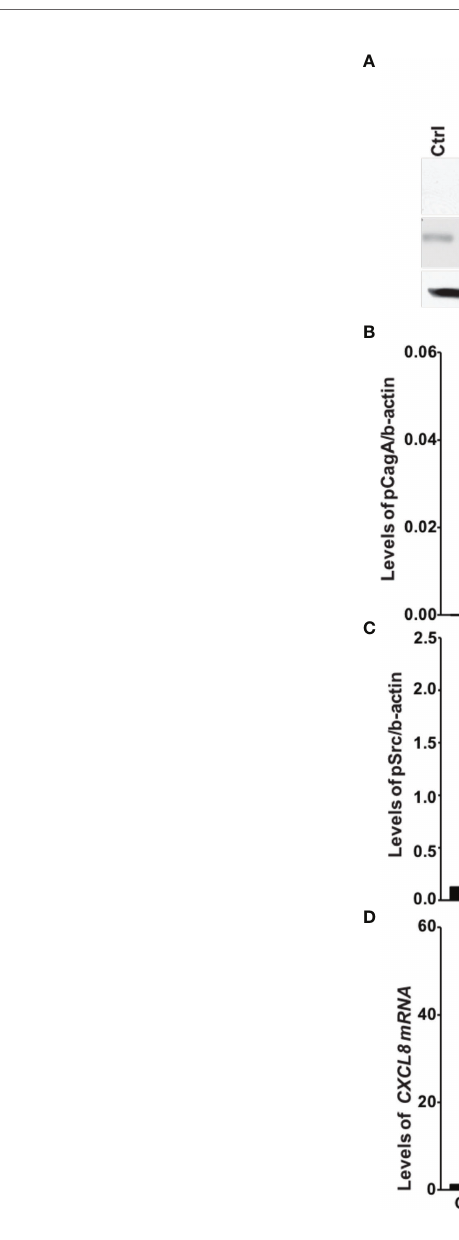
FIGURE 6 | Inhibition of phosphorylation of cagA and Src requires oxidative transformation of curcumin. (A) Western blot analysis of CagA and Src phosphorylation in gastric epithelial cells upon infection with H. pylori treated with curcumin or its stable analogs acetal-curcumin (ACurc) and diacetalcurcumin (DCurc). The blot was probed with anti-phosphoCagA (top) or anti-phosphoSrc antibody (below), and b actin was used as loading control. Representative results from three independent experiments are shown. (B, C) Quanti fi cation of Western blotting results described in (A) . (D) Quanti fi cation of CXCL8 mRNA level in gastric tissue after infection with H. pylori treated with curcumin and its stable analogs. ***P ≤ 0.001, §§§ P ≤